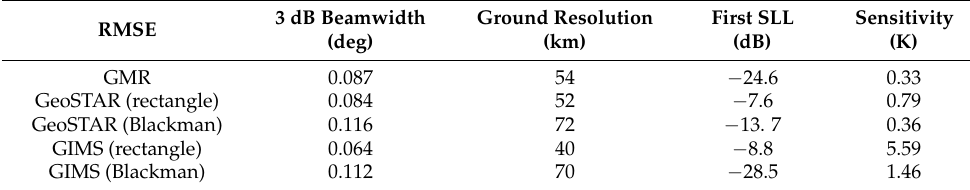
Table 4. Characteristics of GMR, GeoSTAR and GIMS at 50.3 GHz. RMSE